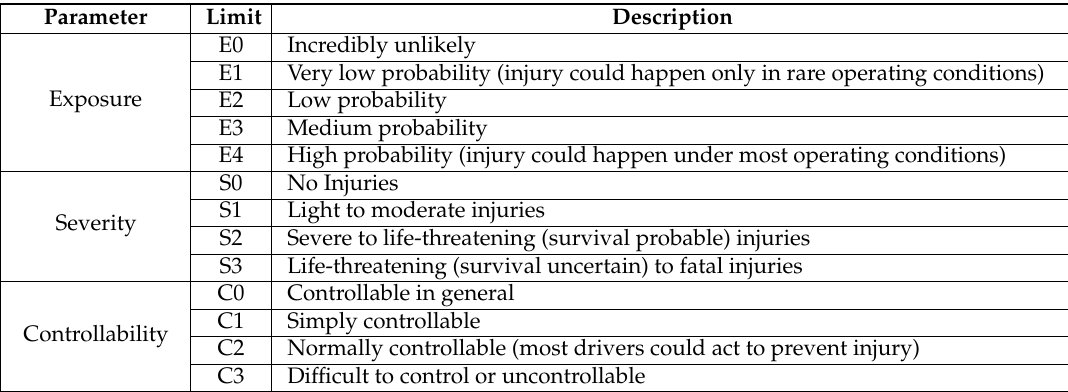
Table 1. Automotive Safety Integrity (ASIL) Parameter Specification Ratings [14].